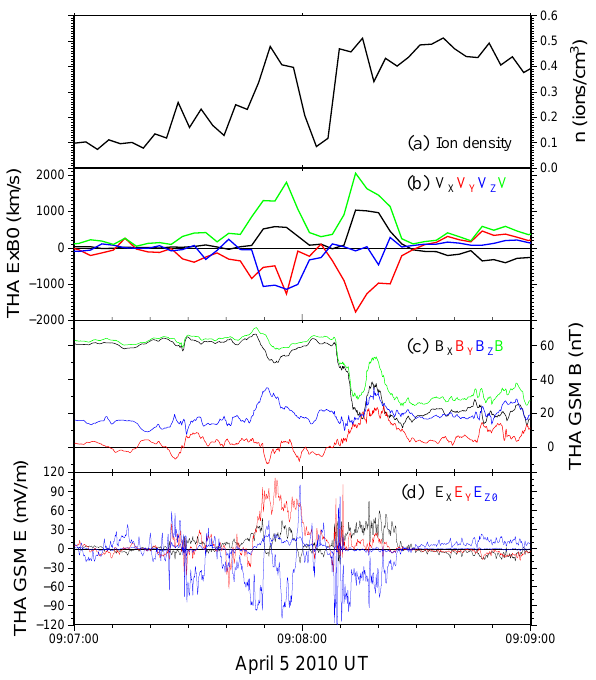
Fig. 2. THEMIS A quantities. (a) Ion density. (b) E × B velocity assuming E · B = 0. (c) GSM magnetic field. (d) GSM electric field with E Z derived from E · B =